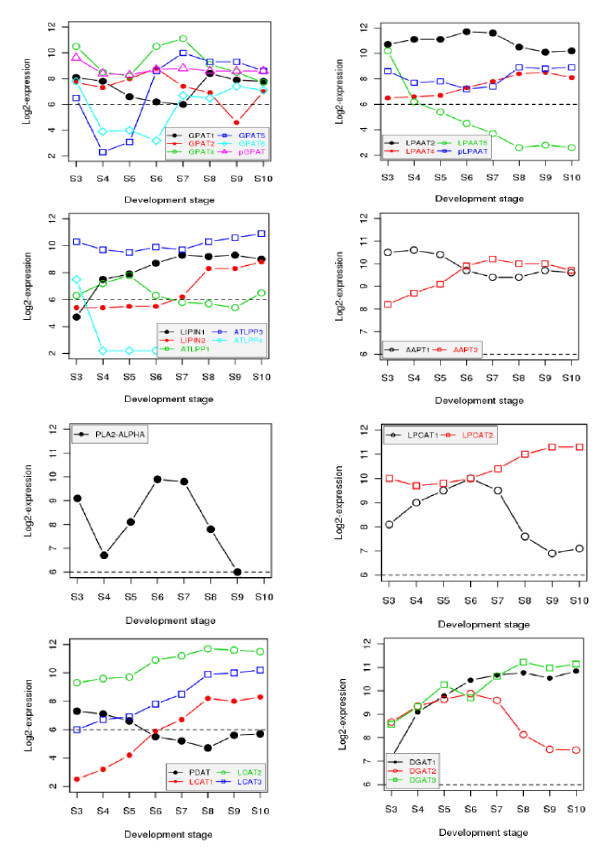
Expression profiles of genes including homologues in the triacylglycerol assembly pathway. The dash line at 6.0 is often used as the cutoff for present (expressed; above the line) or absent (unexpressed; below the line). All expression data were transformed to the log2 scale for plotting the profiles. Genes and homologs in the triacylglycerol (TAG) assembly pathway were identified based on an early survey of Arabidopsis genes involved in acyl lipid metabolism [59], and their AGI identifiers listed in Additional File 3. Refer to [64] for their roles in TAG assembly. The abbreviations of these genes and their encoded enzymes (EC numbers) are as follows: GPAT: sn-glycerol-3-phospahte acyltransferase (EC 2.3.1.15); LPAAT: lysophosphatidic acid acyltransferase (EC 2.3.1.15); PAP: PA phosphatase (EC 3.1.3.4), including LIPIN (PAP1) and LPP (PAP2); AAPT: Aminoalcoholphosphotransferases (EC 2.7.8.1 and EC 2.7.8.2); CPT: cytidine diphosphate (CDP)-choline: 1, 2-diacylglycerol cholinephosphotransferase (EC 2.7.8.2); LPCAT: lysophosphatidylcholine acyltransferase (EC 2.3.1.23); PLA2: Phospholipase A2 (EC 3.1.1.4); PDAT: phospholipid:diacylglycerol acyltransferase (EC 2.3.1.158); LCAT: lechitin:cholesterol acyltransferase (EC 2.3.1.43), these three shown here are PDAT homologs; DGAT: Diacylglycerol acyltransferase (E.C. 2.3.1.20).